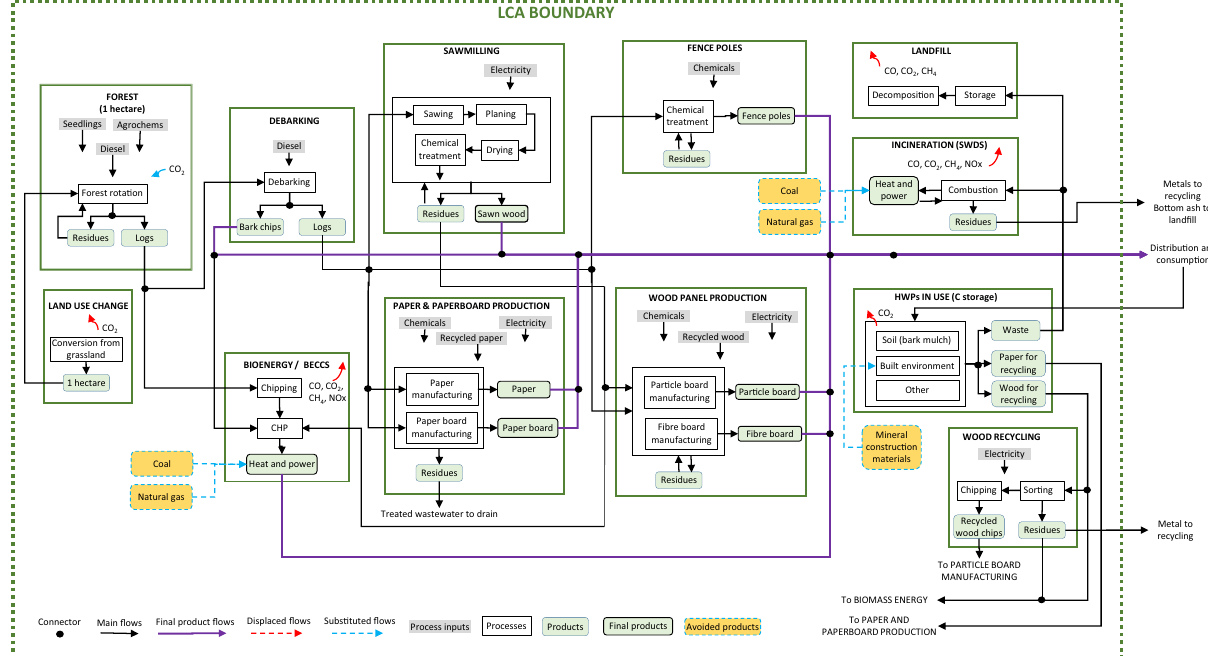
Fig. 4 Main processes and inputs accounted for during primary, secondary and end-of-life uses of harvested wood products (HWP) within consequential life cycle assessment boundaries. Main processes arise during each stage of the value chain, including forest establishment (and associated land use change from grassland); wood processing (debarking, milling, wood panel and paper production from primary and secondary wood fl ows); storage of carbon in HWP (primary and secondary wood products); recycling and disposal of HWP (primary and secondary wood products), including incineration (with energy recovery) and land fi ll; bioenergy generation (with bioenergy carbon capture and storage (BECCS) in later years); substitution of fossil fuels for energy generation; substitution of mineral construction